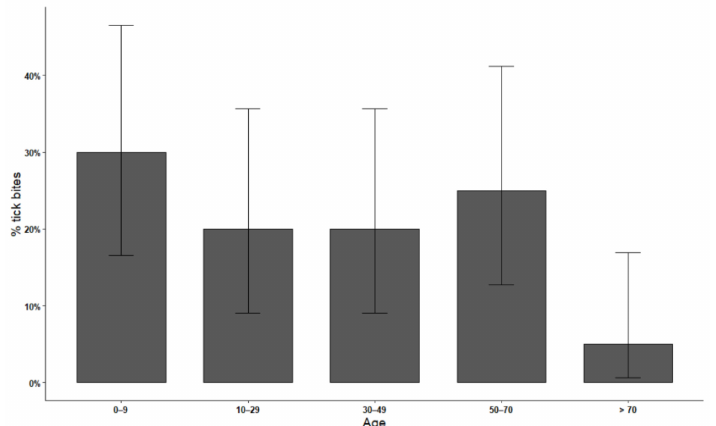
Figure 1. Prevalence of tick bites recorded in 2018–2019 by collaborating physicians, with 95% CI, according to age categories (in